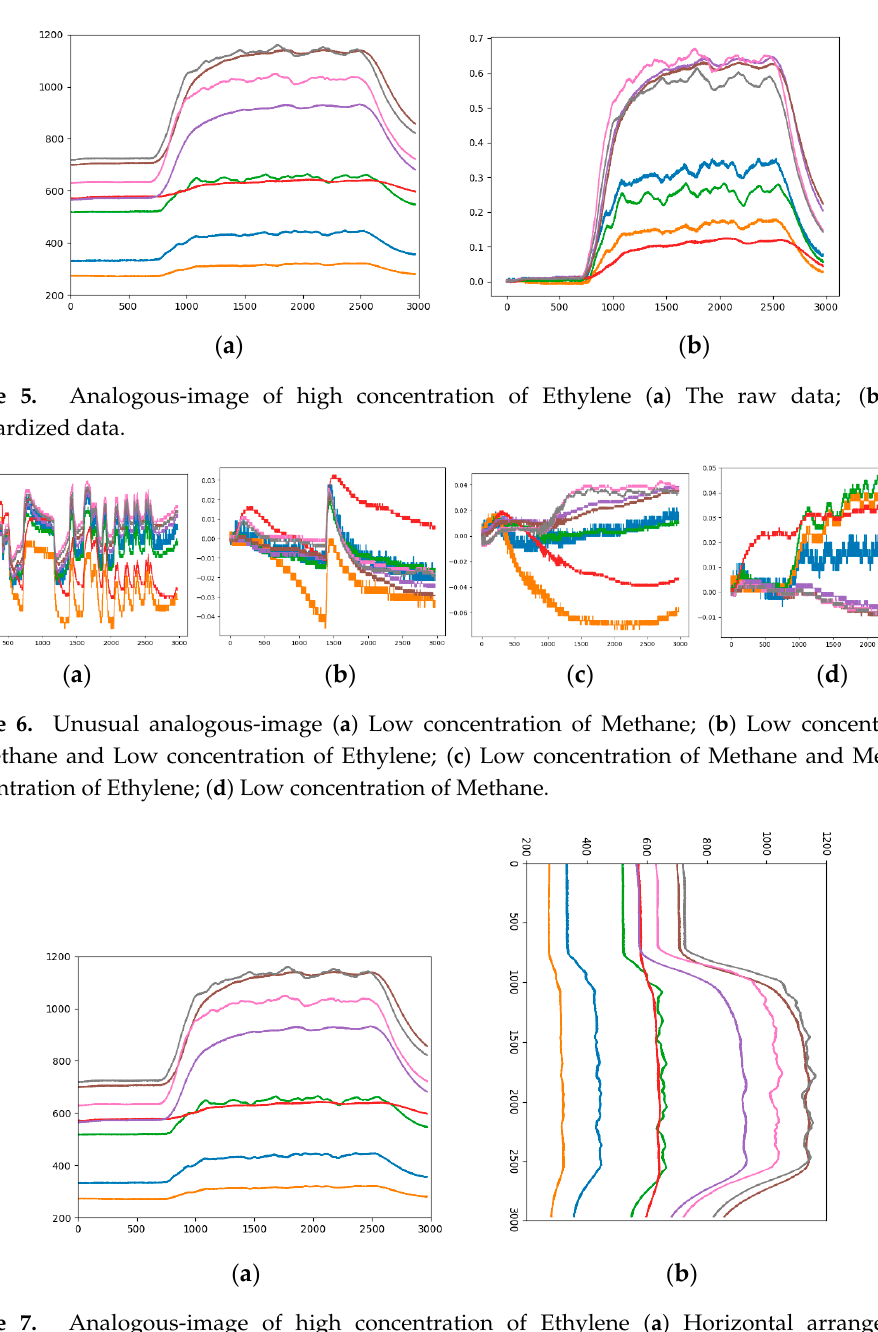
Figure 7. Analogous-image of high concentration of Ethylene ( a ) Horizontal arrangement, ( b ) Vertical arrangement.